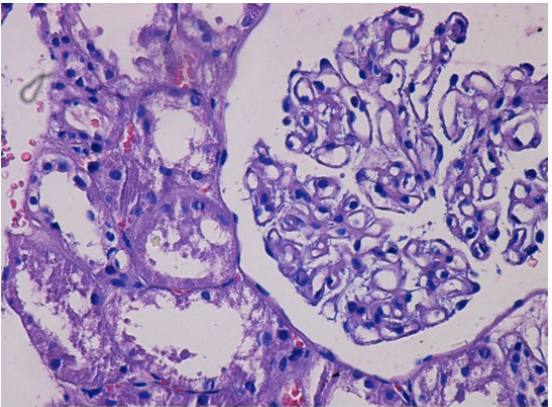
Figure 1. Renal biopsy. Class V lupus nephropathy. Rigid capillary loops, thickening of the glomerular basement membrane (PAS stainx400)